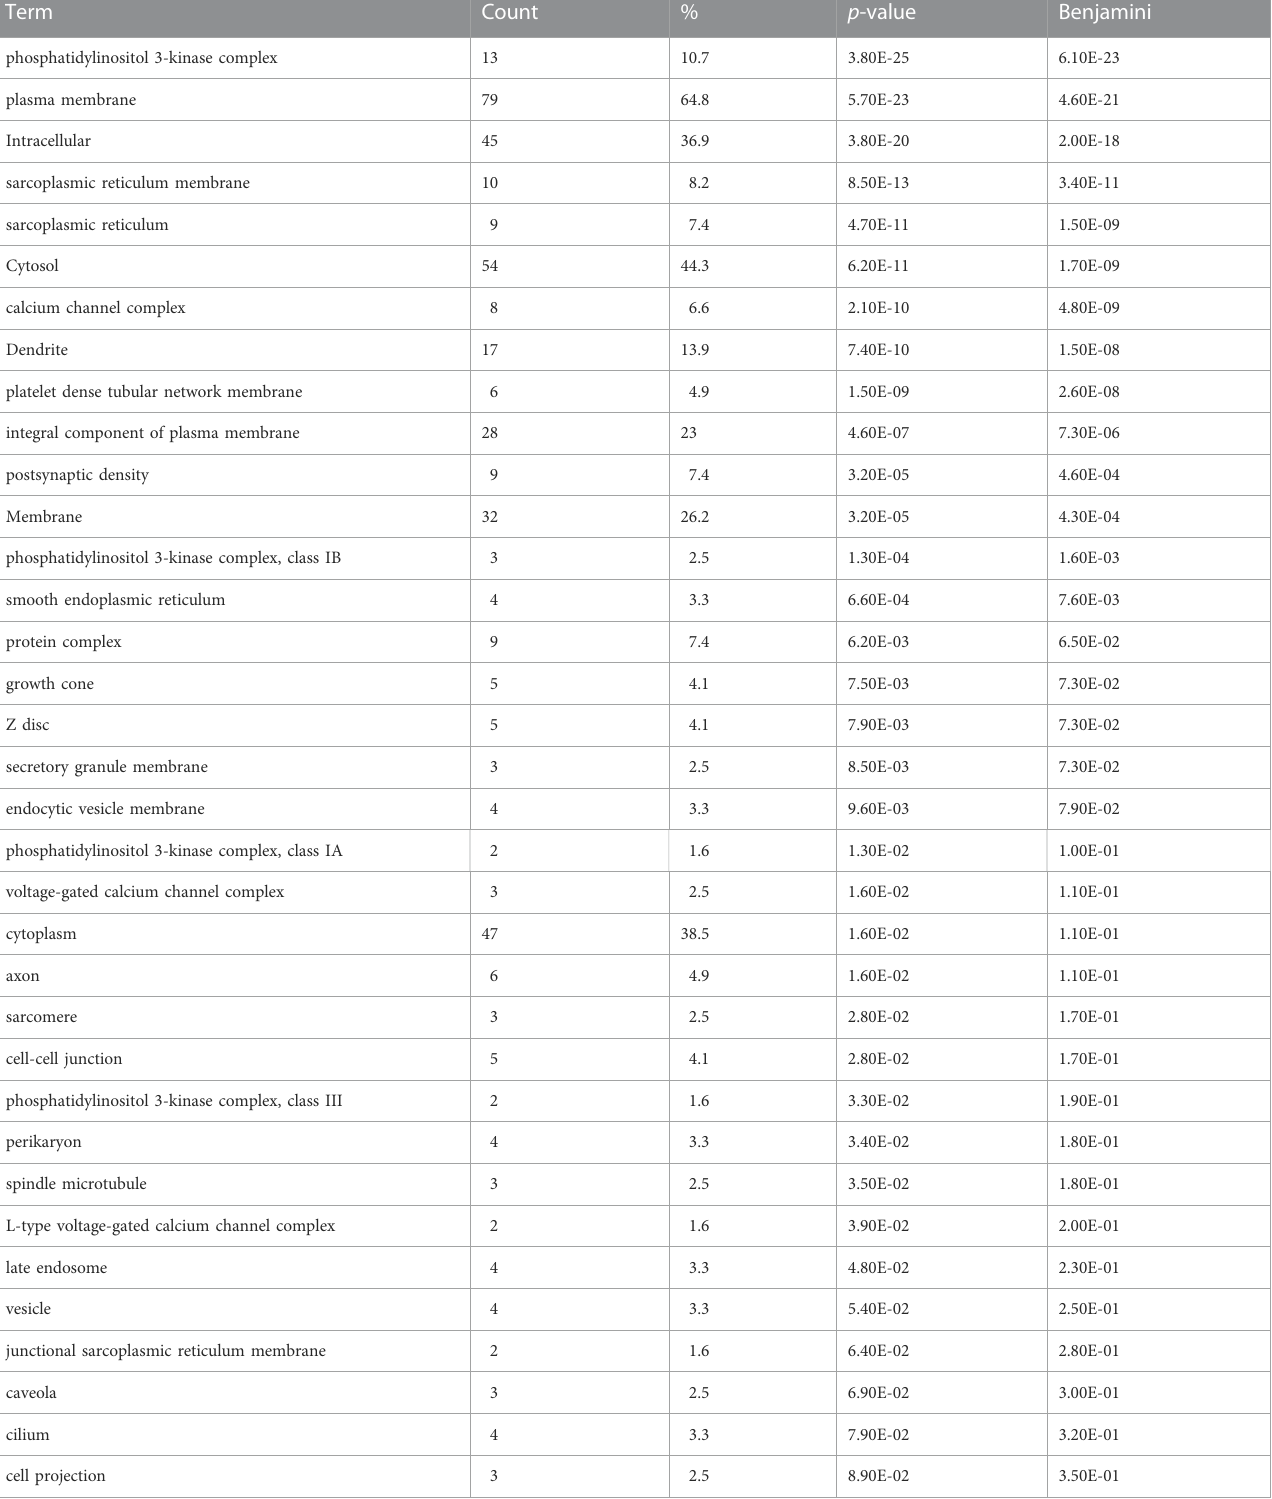
TABLE 4 Gene Ontology Enrichment – Cellular Compartment. Gene ontology cellular compartment enrichment analysis performed on the set of 125 shrew ( Cryptotis parva ) candidate genes for emesis. Term corresponds to the gene ontology term, count indicates how many genes within the 125 candidate gene set contained